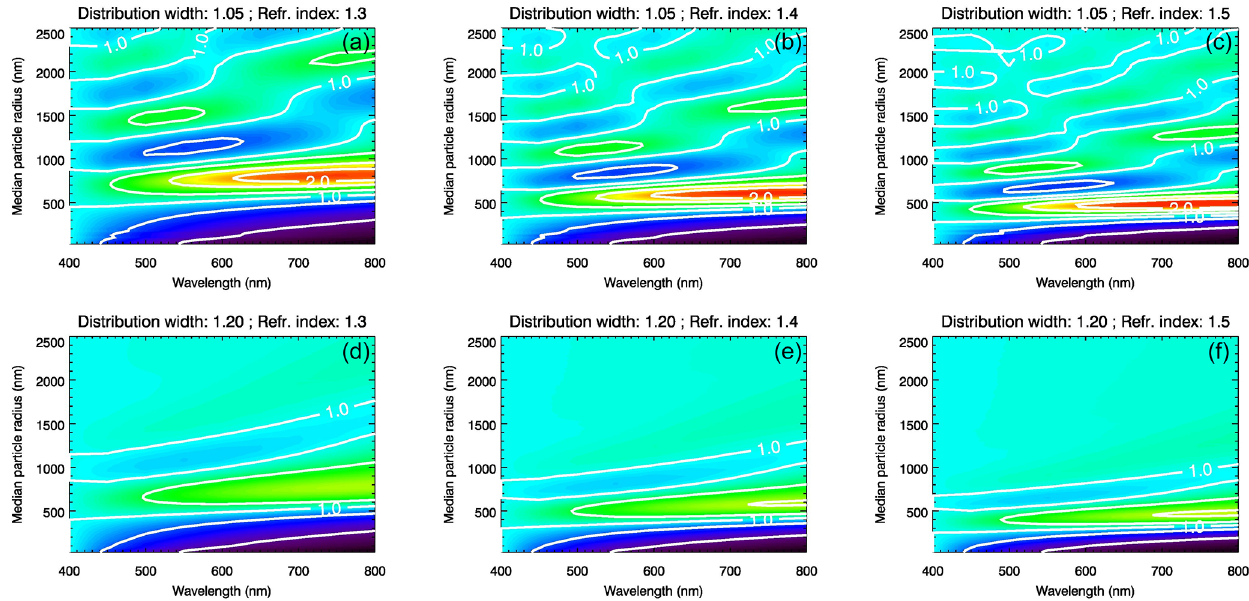
Figure 1. Spectral and radius dependence of aerosol extinction coefficients (normalized to 400nm) determined by Mie calculations assuming a mono-modal log-normal particle size distribution with a geometric width of S = 1 . 05 (a, b, c) and S = 1 . 2 (d, e, f) and real parts of the refractive index of 1.3 (a, d) , 1.4 (b, e) and 1.5 (c, f) . Contour levels are 0.3, 0.7, 1.0, 1.3, 1.7, 2.0 and 2.3.